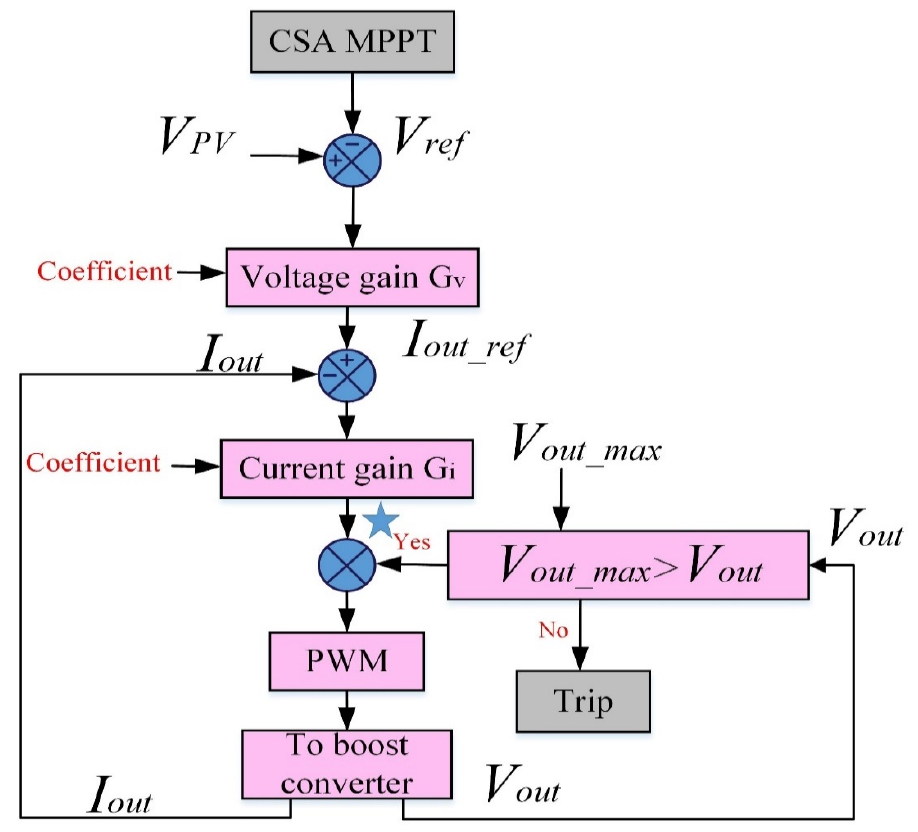
Figure 7. CSA MPPT with closed-loop PID Controller.